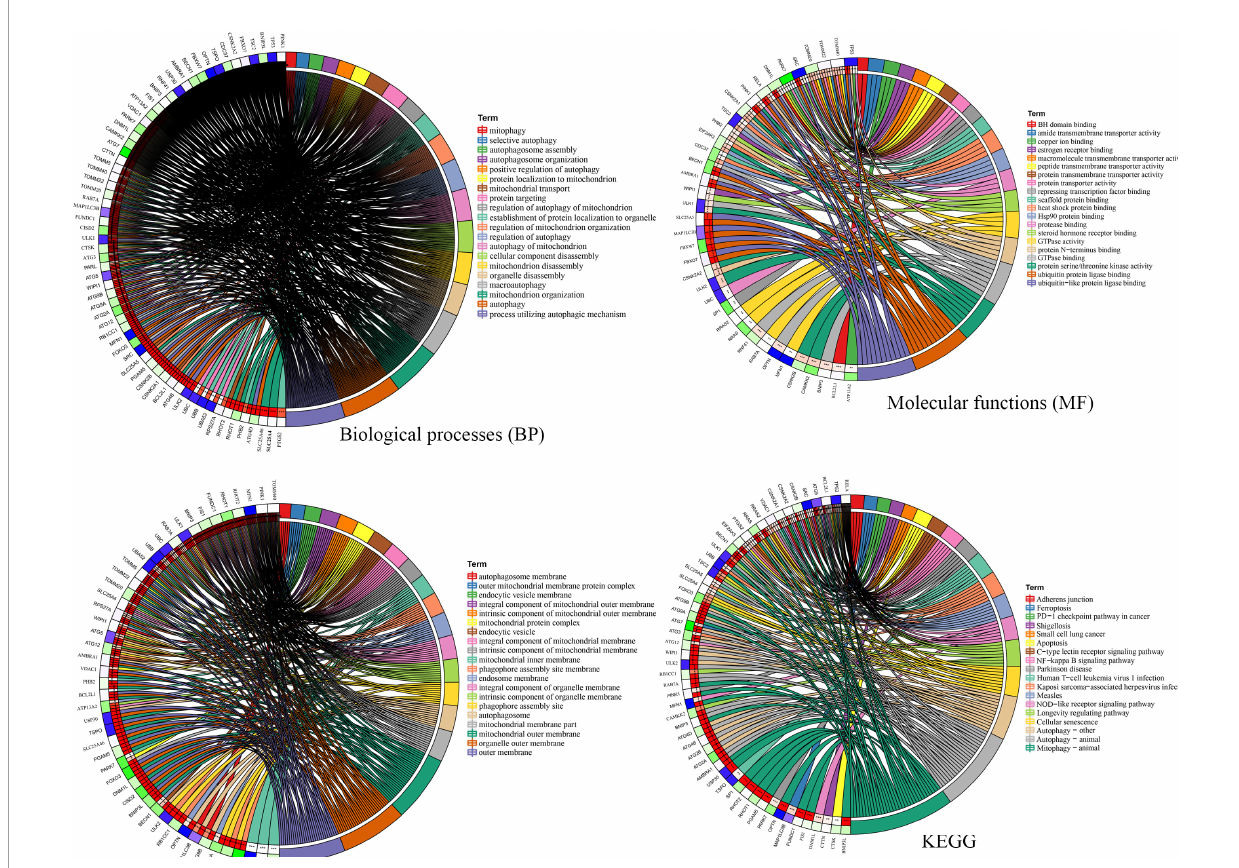
FIGURE3 Gene Ontology (GO) and Kyoto Encyclopedia of Genes and Genomes Enrichment analysis of the differentially expressed mitophagy-related genes. BP, biological process; CC, cellular component; MF, molecular